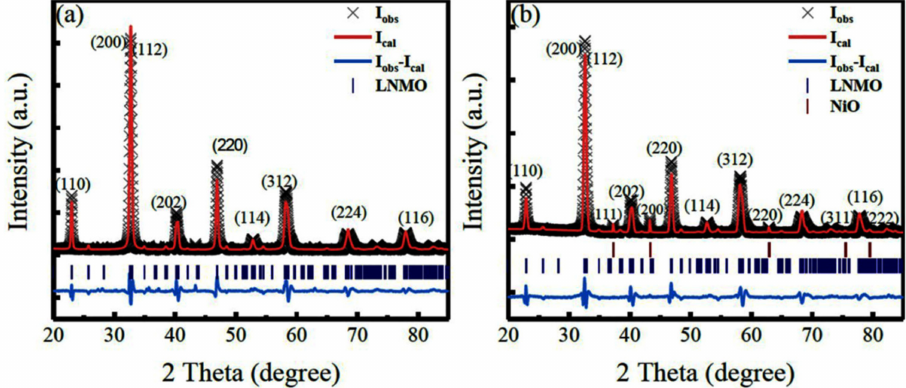
Figure 1. XRD patterns of the as-synthesized LNMO samples. ( a ) LNMO NPs and ( b ) LNMO NRs. Table 1. Structural parameters obtained from Rietveld refinements of the XRD data of the as- synthesized LNMO NPs and